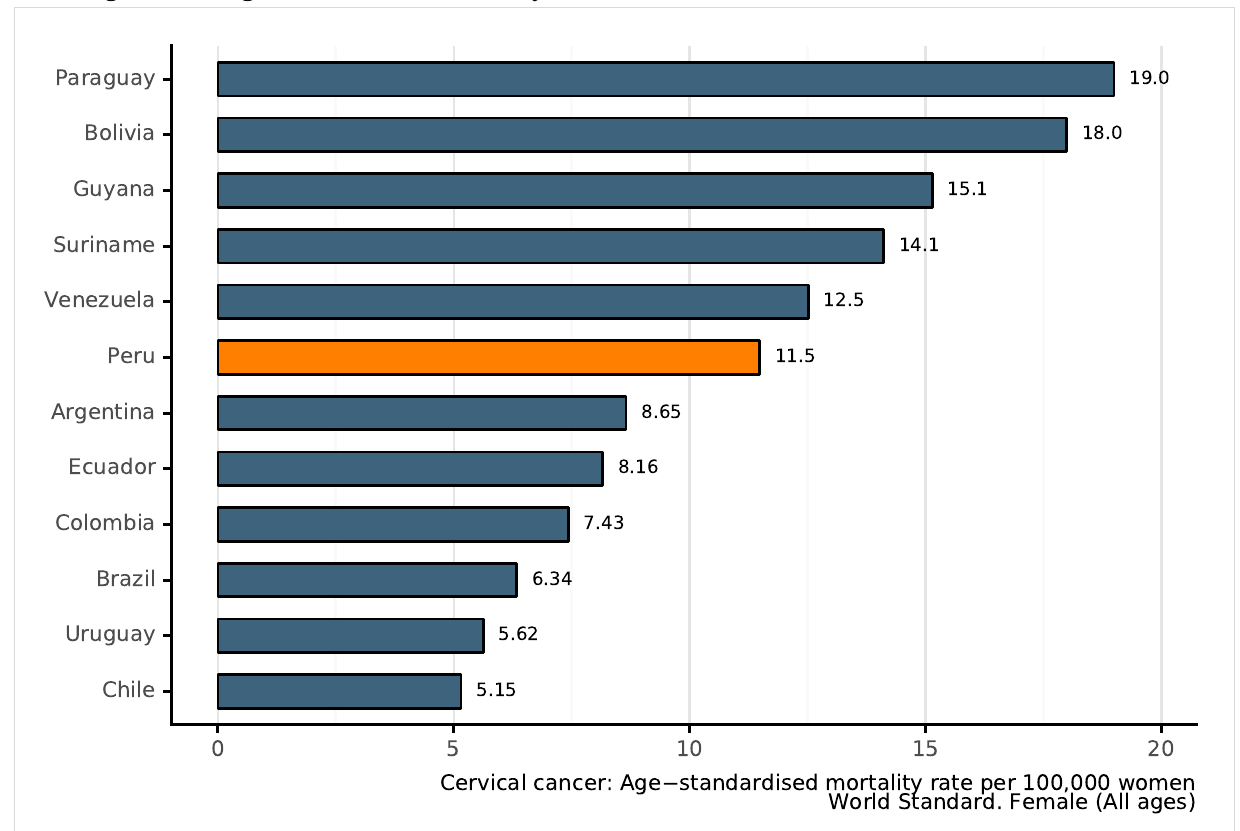
Cervical cancer: Age standardised mortality rate per 100,000 women World Standard. Female (All